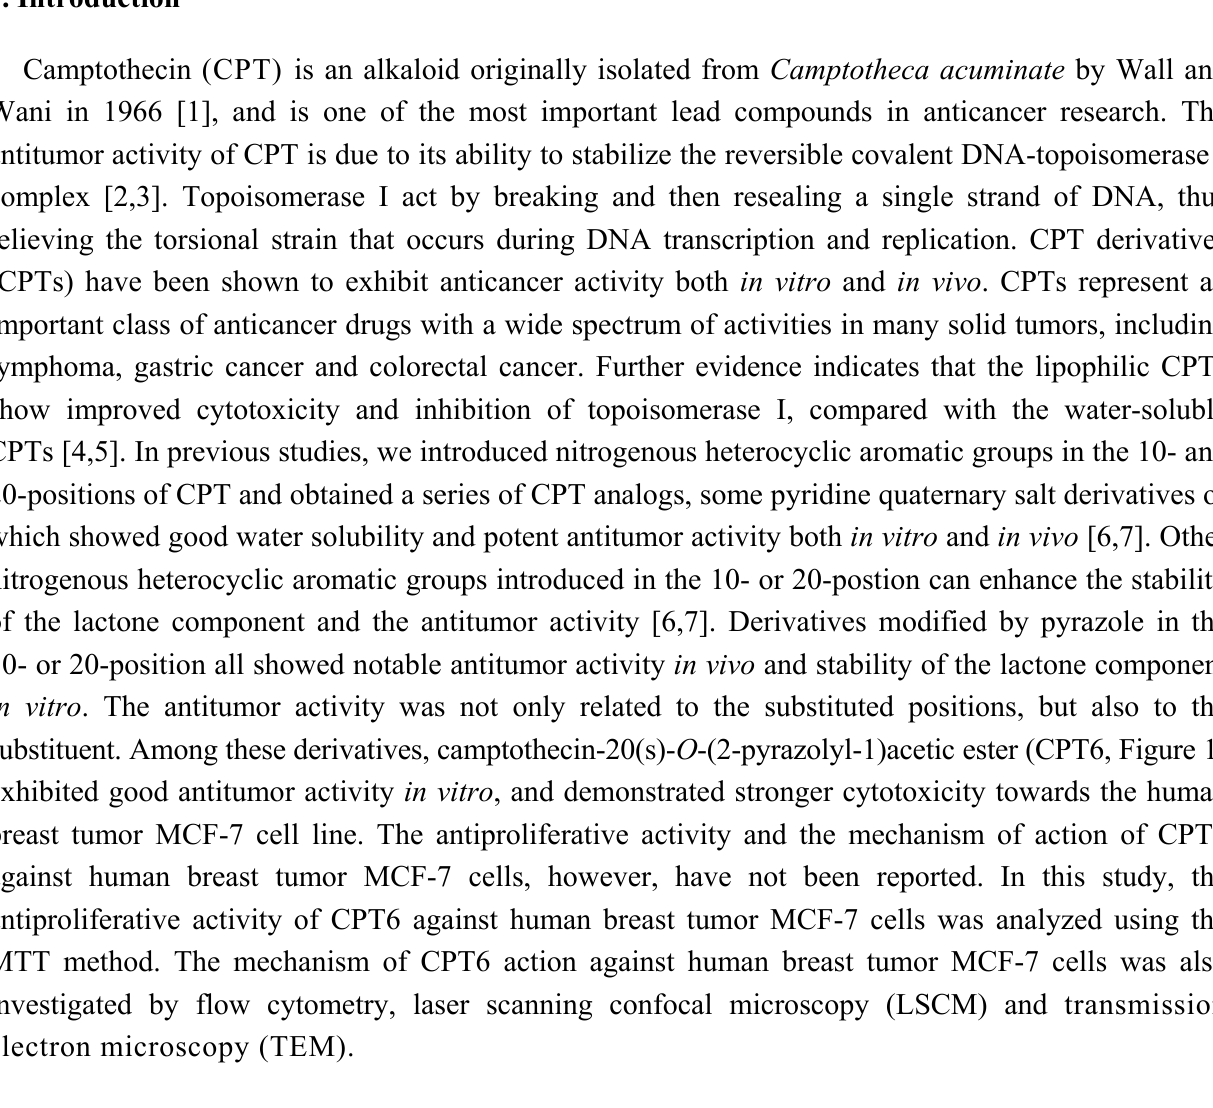
Figure 1. Chemical structure of camptothecin-20(s)- O -(2-pyrazolyl-1)acetic ester